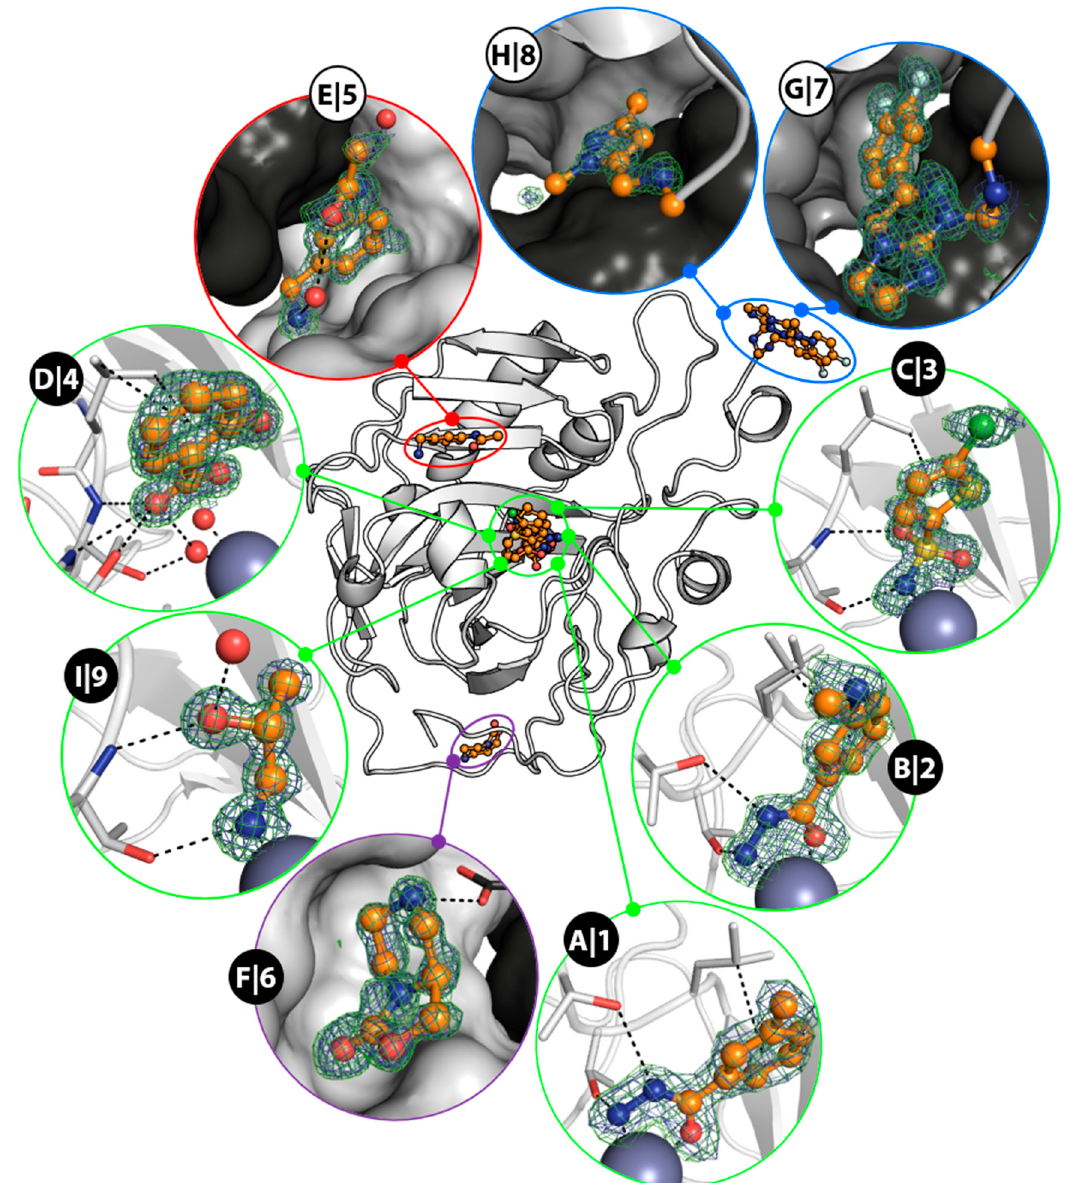
Figure 2. Overview of fragment binding sites. Fragments are shown in orange with omit 2mFo − DFc maps in blue at 1 σ and mFo − DFc maps in green at 3 σ . Active site binders are shown with the interacting amino acids in stick representation. Remotely binding fragments are shown with the surface representation of adjacent protein molecules. Hydrazides 1 ( A ) and 2 ( B ) and sulfonamide 3 ( C ) coordinate to the Zn II cofactor; salicylic acid ( 4 , D ) coordinates to the Zn II -bound water molecule. Anilide 5 ( E ) is accommodated in a hydrophobic cavity on the rim of the funnel-shaped active site, which is covered by a proline residue of a symmetry mate and additionally entraps a water molecule. Cyclic carbamate ( S )- 6 ( F ) coordinates to the C -terminus and a Trp sidechain and donates a hydrogen bond to the PCMB molecule of a symmetry mate. Fluorinated compound 7 ( G ) and pyrazole 8 ( H ) are covalently attached to the remainder of the fusion-protein tag from protein expression.